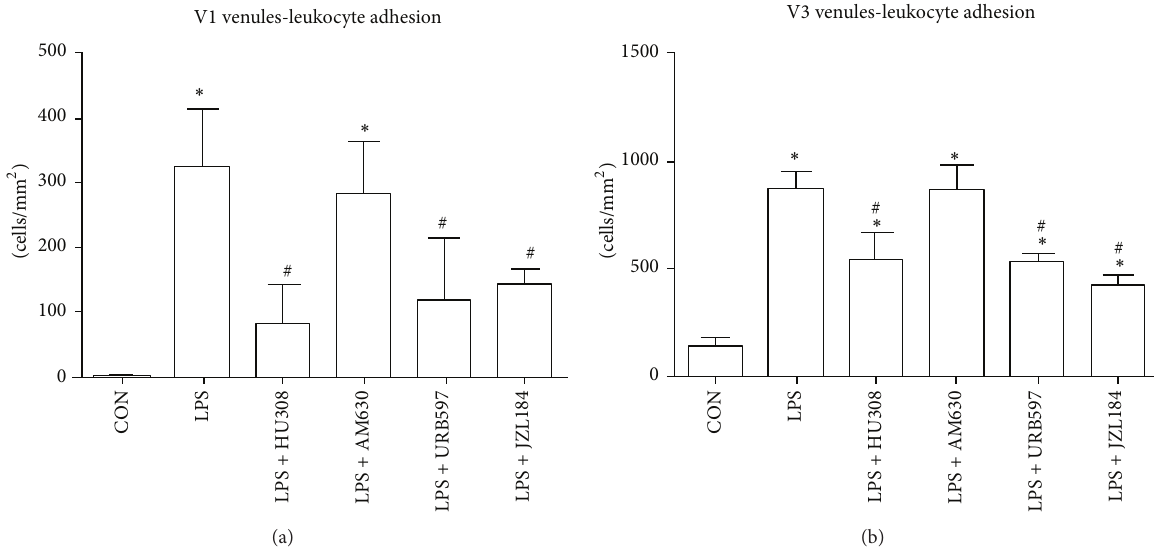
Figure 1: (a) Adherent leukocytes in collecting venules (V1; > 50 𝜇 m vessel diameter). (b) Adherent leukocytes in postcapillary venules (V3; < 50 𝜇 m vessel diameter). Control group (CON); endotoxemia group LPS (5 mg/kg); LPS + HU308 (2.5 mg/kg), a CB AM630 (2.5mg/kg), a CB 2 receptor antagonist/inverse agonist; LPS + URB597 (0.6 mg/kg), a FAAH inhibitor; and LPS + JZL184 (16mg/kg) a MAGL inhibitor. In every animal six V1 venules and six V3 venules were analyzed ( 𝑛 = 3 –5 mice/group). Data presented as mean ± standard deviation. ∗ 𝑃 < 0.05 versus control. # 𝑃 < 0.05 versus LPS.